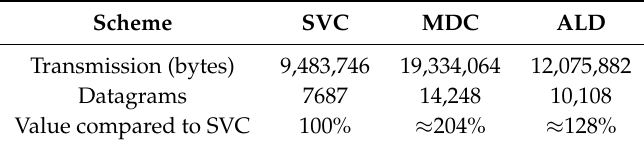
Table 8. Transmission byte-cost as for the highest quality.